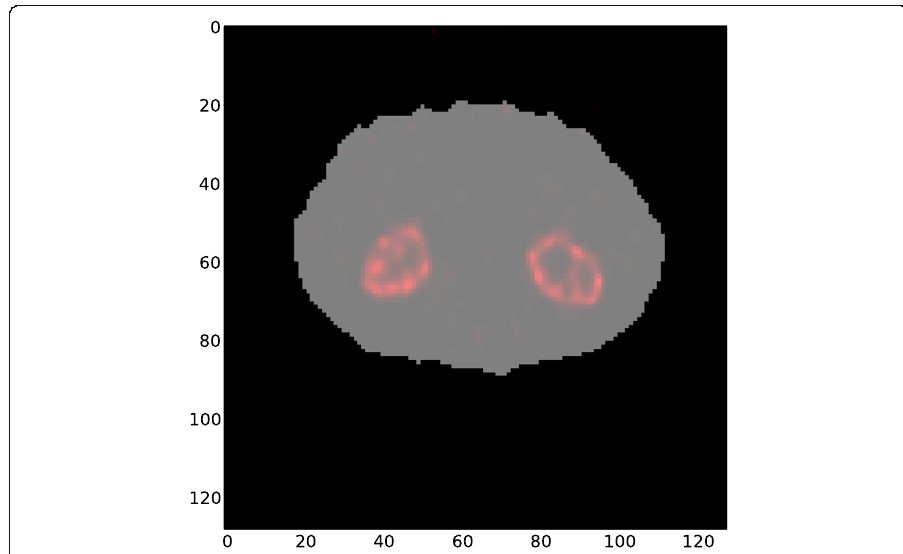
Fig. 3 Attenuation map (shown in gray) and reconstructed SPECT image (kidney region displayed only, shown in red) of a representative patient,